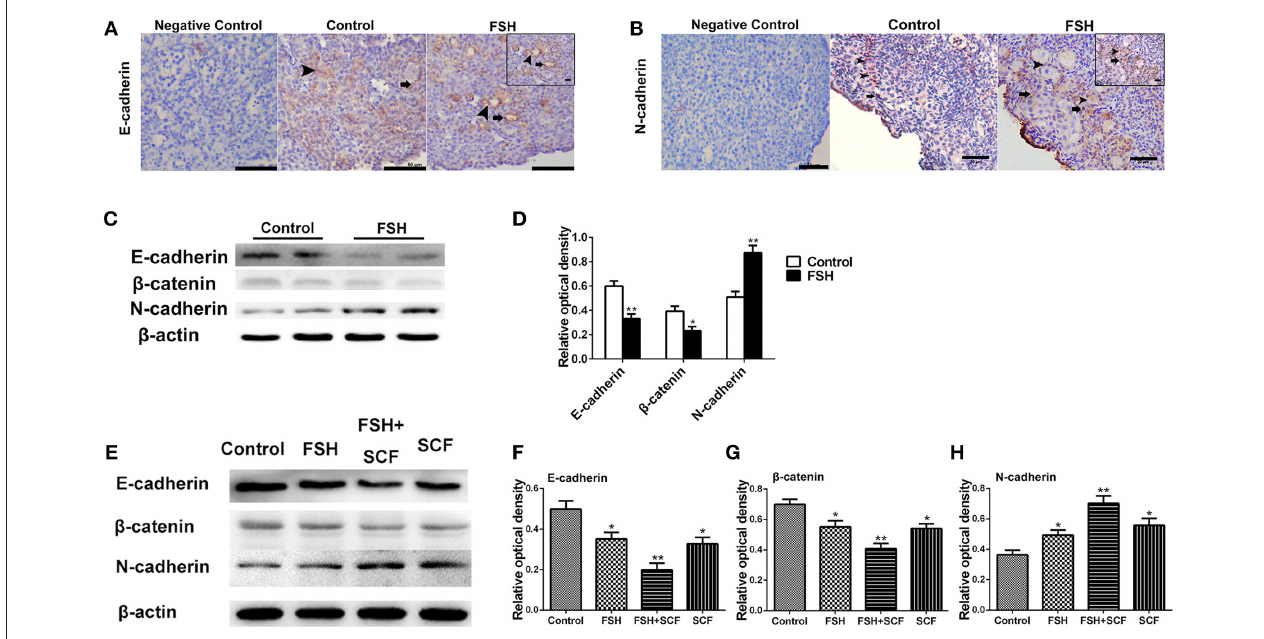
FIGURE 10 | Combined effects of FSH and SCF on the expression of E-cadherin and N-cadherin. Four-day-old chickens were treated with FSH for 2 days in vivo . Brown stain represents immunohistochemical antigen. ( A inset) Arrowheads and arrows represent oocyte-oocyte contact sites and somatic cells stained with E-cadherin, respectively. (C,D) Western blot and gray analysis indicate that FSH inhibited the E-cadherin and its partner β -catenin expression in vivo . ( B inset) Arrowheads and arrows represent oocytes and somatic cells stained with N-cadherin, respectively. (C,D) Western blot and gray analysis indicate that FSH promoted the N-cadherin protein expression in vivo . (E–H) 4-day-old chicken ovaries were treated by FSH and SCF for 2 days in vitro . Western blot and gray analysis indicate that SCF enhanced the effect of FSH in promoting N-cadherin expression in vitro . Meanwhile, SCF augmented the inhibitory effect of FSH on E-cadherin and β -catenin expression. T -tests were used to determine statistically significant differences. The values are the mean ± SEM of six experiments. Asterisks indicate significant differences (* P < 0.05, ** P < 0.01). Scale bars: inset in (A,B) , 10 µ m.